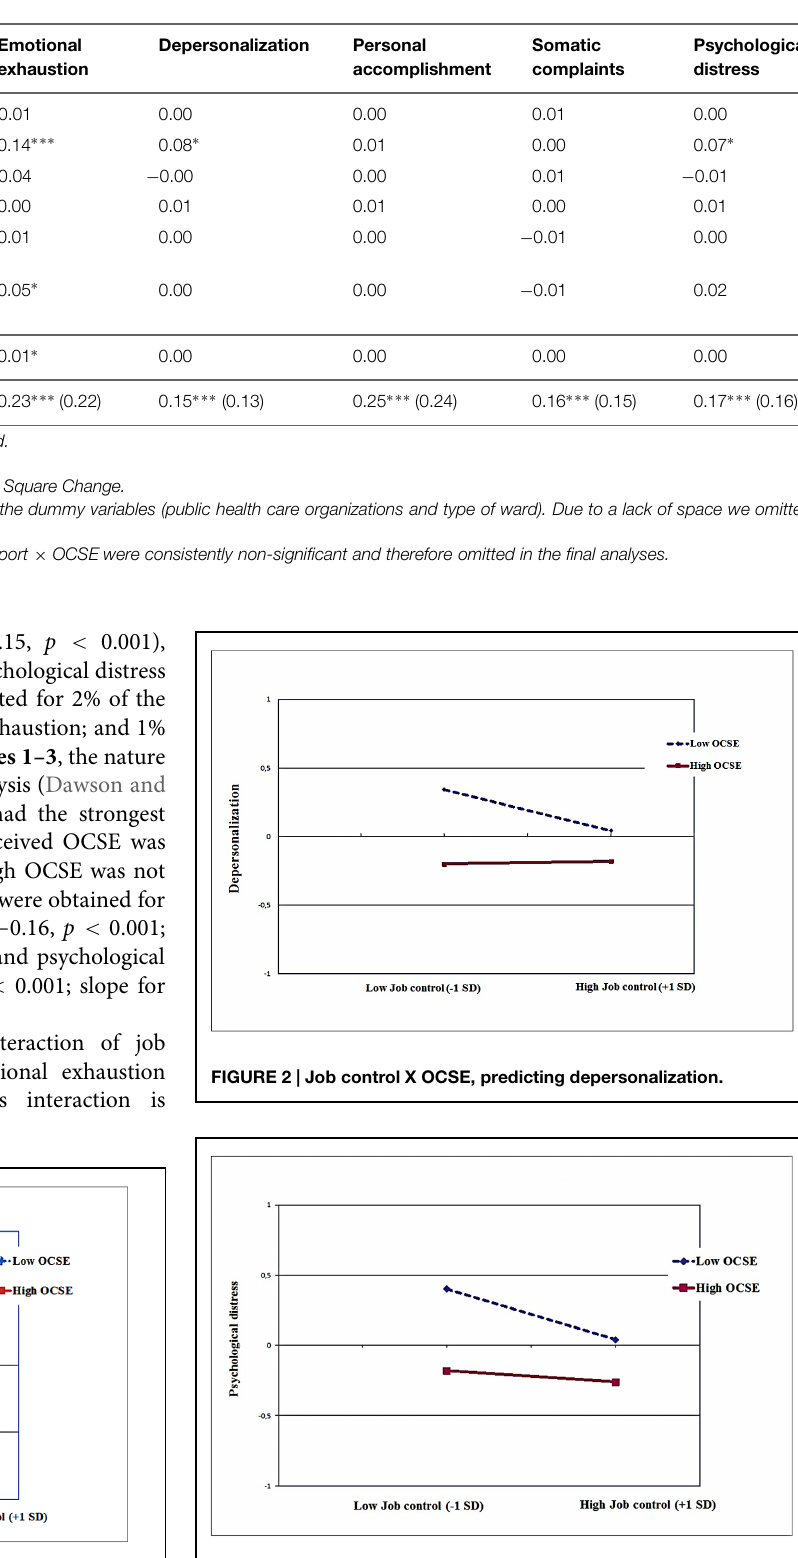
FIGURE 3 | Job control X OCSE, predicting psychological